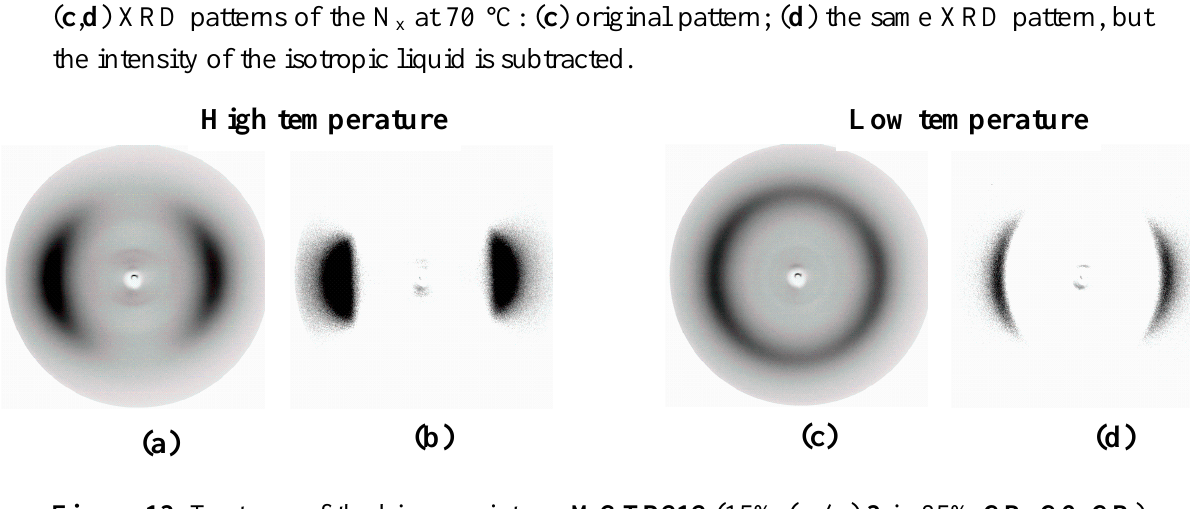
Figure 13. Textures of the binary mixture, MGTP212 (15% (w/w) 3 in 85% CB_C9_CB ), at U = 0 V between untreated glasses observed in the same region upon cooling between crossed polarizers: ( a ) schlieren texture in the high-temperature nematic N phase at 113 °C; ( b ) fan-like texture of the low-temperature N phase at 100 °C and ( c ) sheared texture of x the low-temperature N phase at 84 x